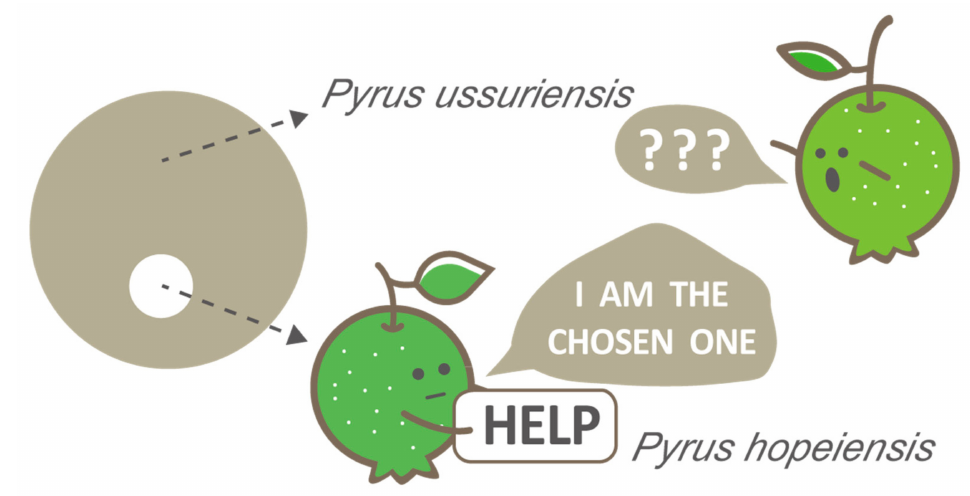
Figure 5. Integrative evidence indicates that the locally endemic Pyrus hopeiensis is a synonym of P. ussuriensis and should be excluded from the list of key protected wild